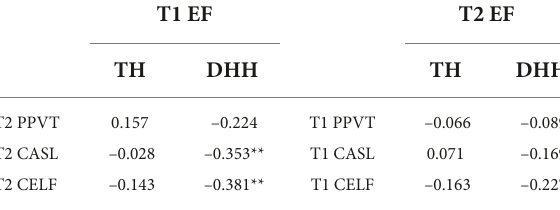
TABLE 3 T1 and T2 longitudinal language/EF correlations.